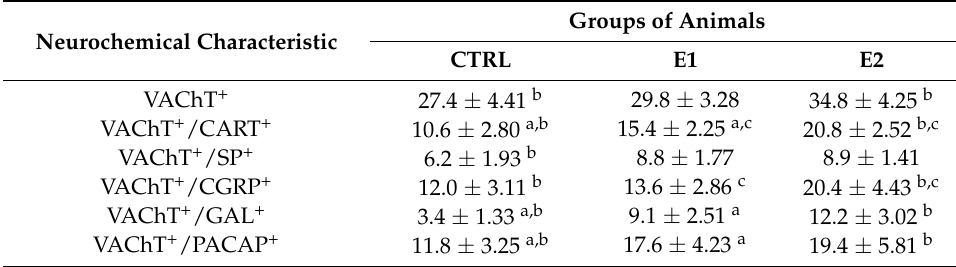
Table 1. Neurochemical characteristics and changes in neuropeptide expression in intrahepatic sympathetic nerves under physiological conditions and after bisphenol A administration. The studied groups of animals were: CTRL—control. E1—experimental group 1 (low dose of bisphenol A), E2—experimental group 2 (high dose of bisphenol